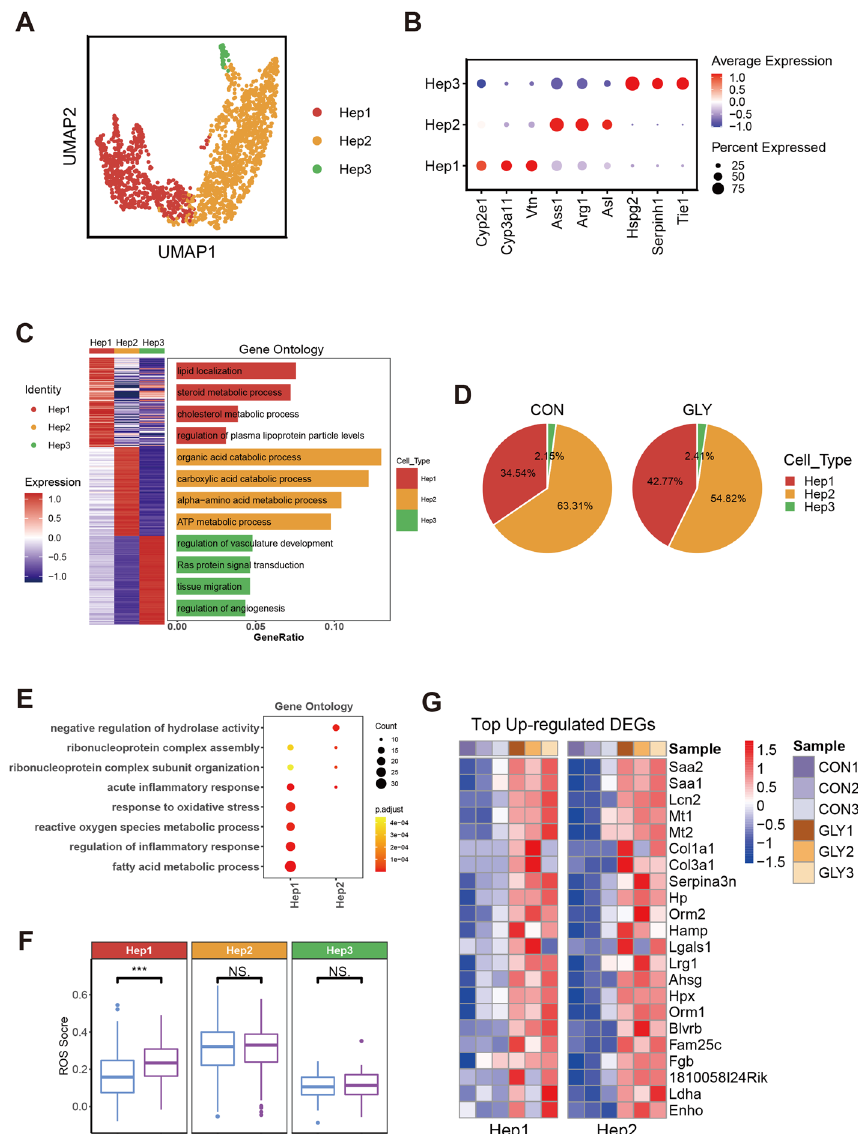
Fig. 3 Specific changes of hepatocyte subsets between control and GLY groups. A UMAP plot for the three subtypes of hepatocytes termed Hep1, Hep2, and Hep3. B The expression of specific marker genes in hepatocyte subtypes. C Heatmap of DEGs for the three cell subtypes and their corresponding functional enrichment analysis. D Pie plots showing proportional changes of each subtype within the control and GLY groups. E GO analysis for upregulated DEGs of Hep1 and Hep2. F Boxplots of ROS score for each cell subtype. The middle lines indicate median values; boxes range from the 25th to 75th percentile. P value is from wilcox. test (unpaired and two-tailed); *** P < 0.001, NS, not significant. G Heatmaps of upregulated genes for Hep1 and Hep2 after GLY